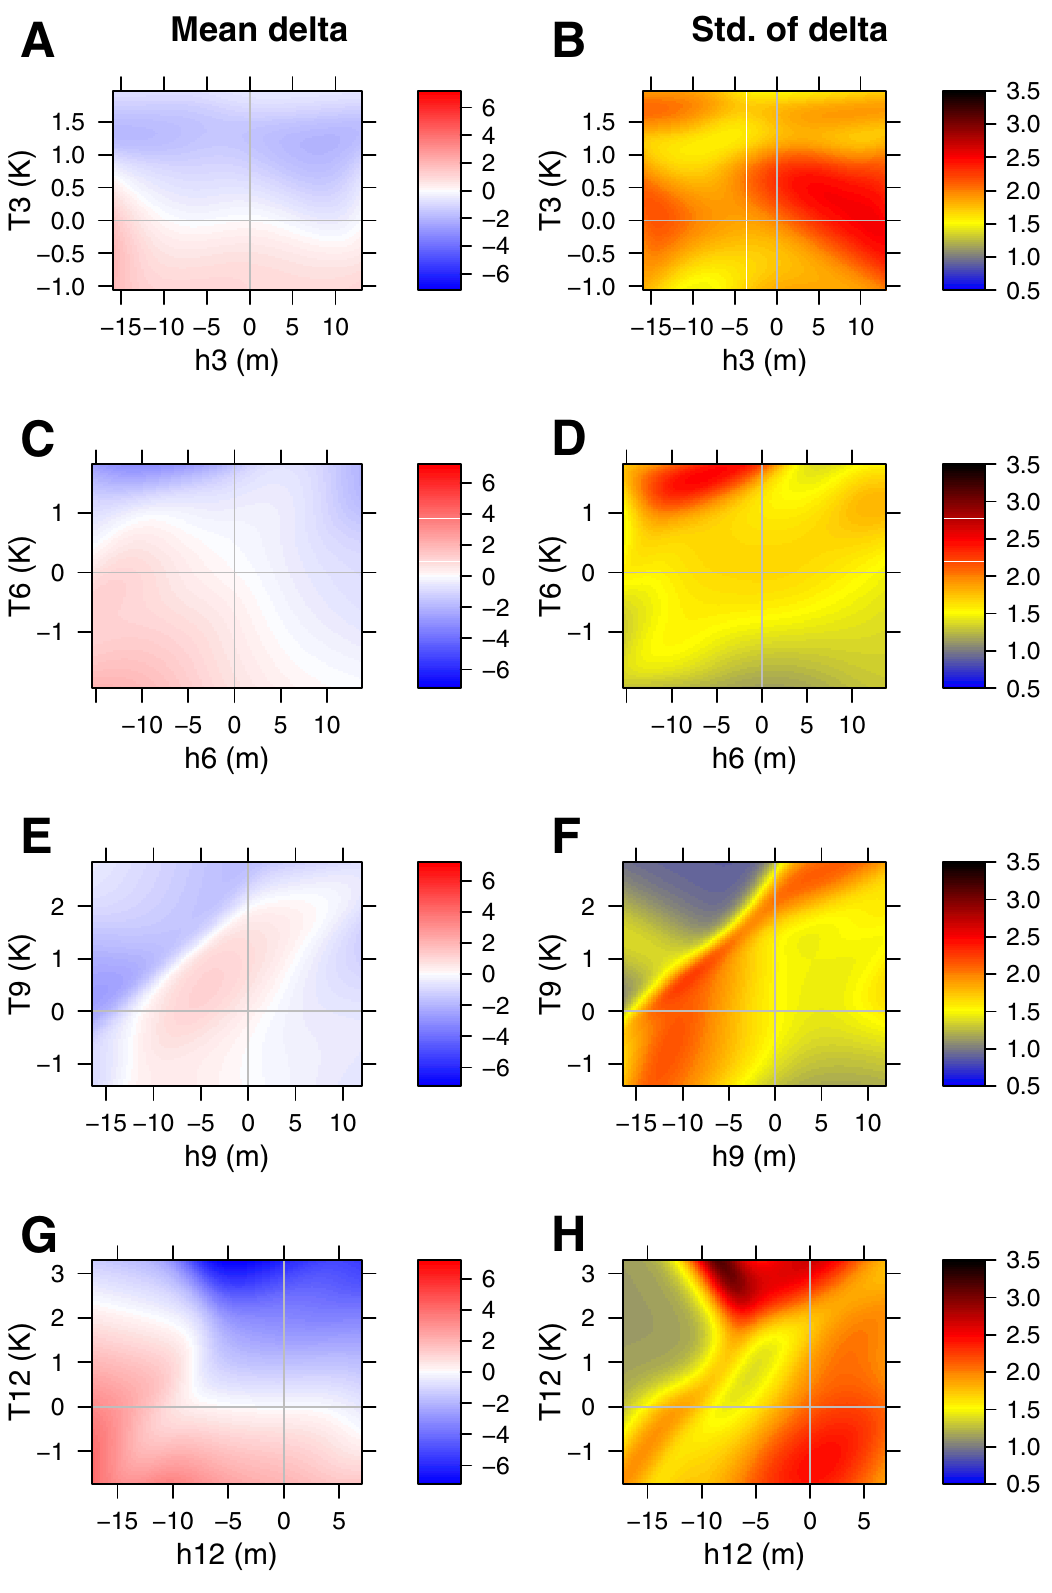
1 ]. Joint tendency